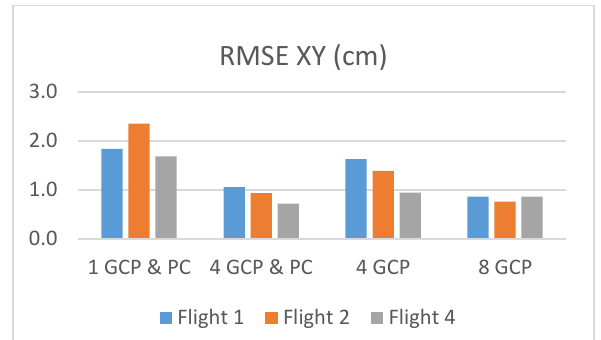
Figure 8. RMSE in horizontal coordinates of CP with